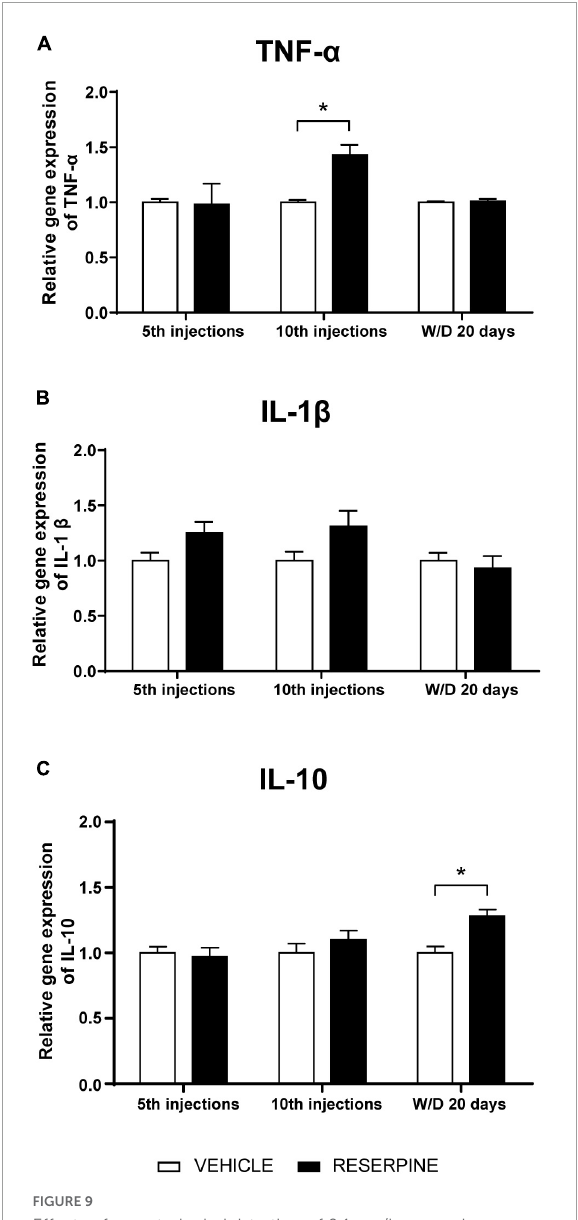
FIGURE9 Effects of repeated administration of 0.1 mg/kg reserpine ( n = 6–8) on gene expression of the cytokines TNF- α (A) , IL-1 β (B) , and IL-10 (C) in the dorsal striatum of rats submitted to 5 and 10 injections of reserpine or vehicle and 20 days after the last injection. Data are shown as mean + SEM, * p < 0.05 comparing Reserpine and Vehicle groups (ANOVA followed by Sidak’s